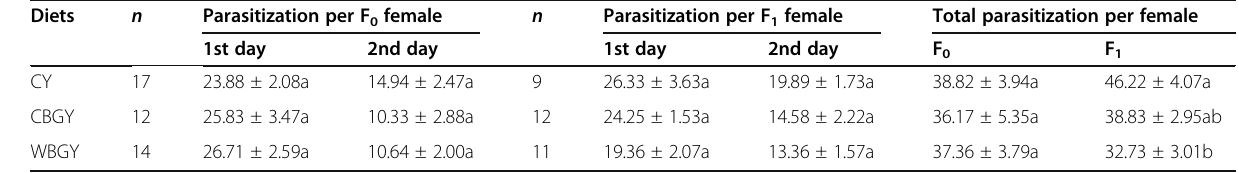
Table 6 Trichogramma evanescens parasitizing eggs of Ephestia kuehniella fed on three different diets Diets